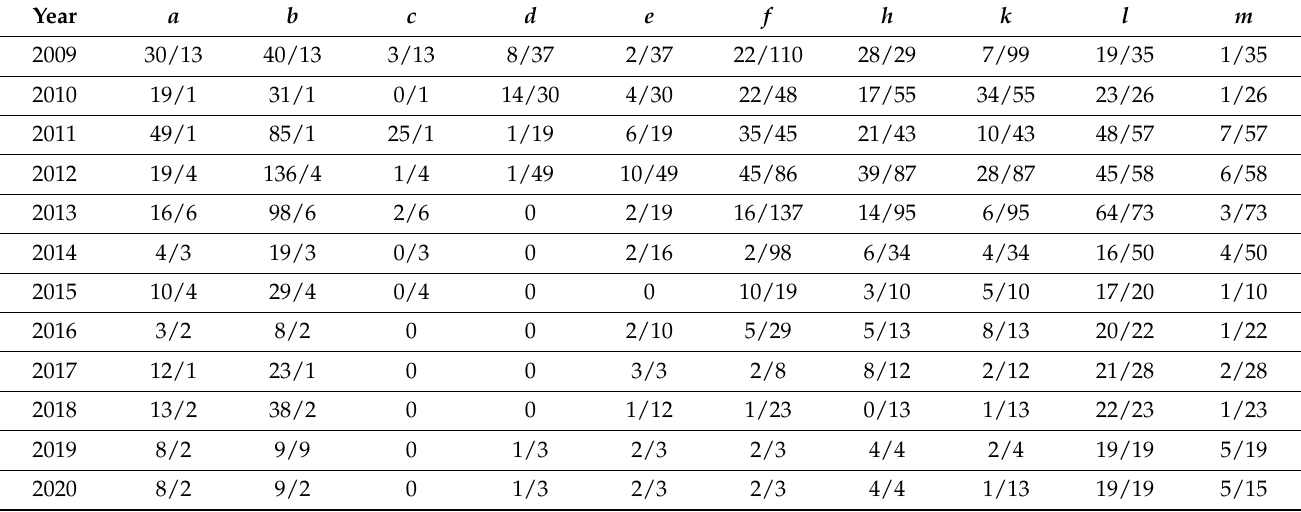
Table 1. Vital rates of A. albana as the entries of 12 annual PPMs (extracted from Table 3 in